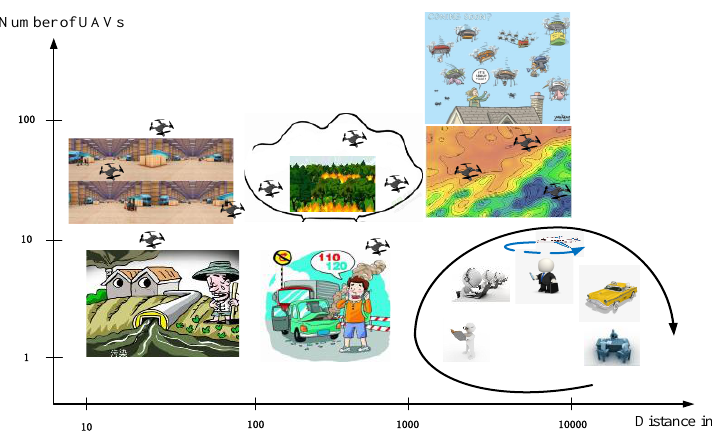
Figure 1. Application areas over a range of distance vs. number of Unmanned Aerial Vehicles (UAVs).